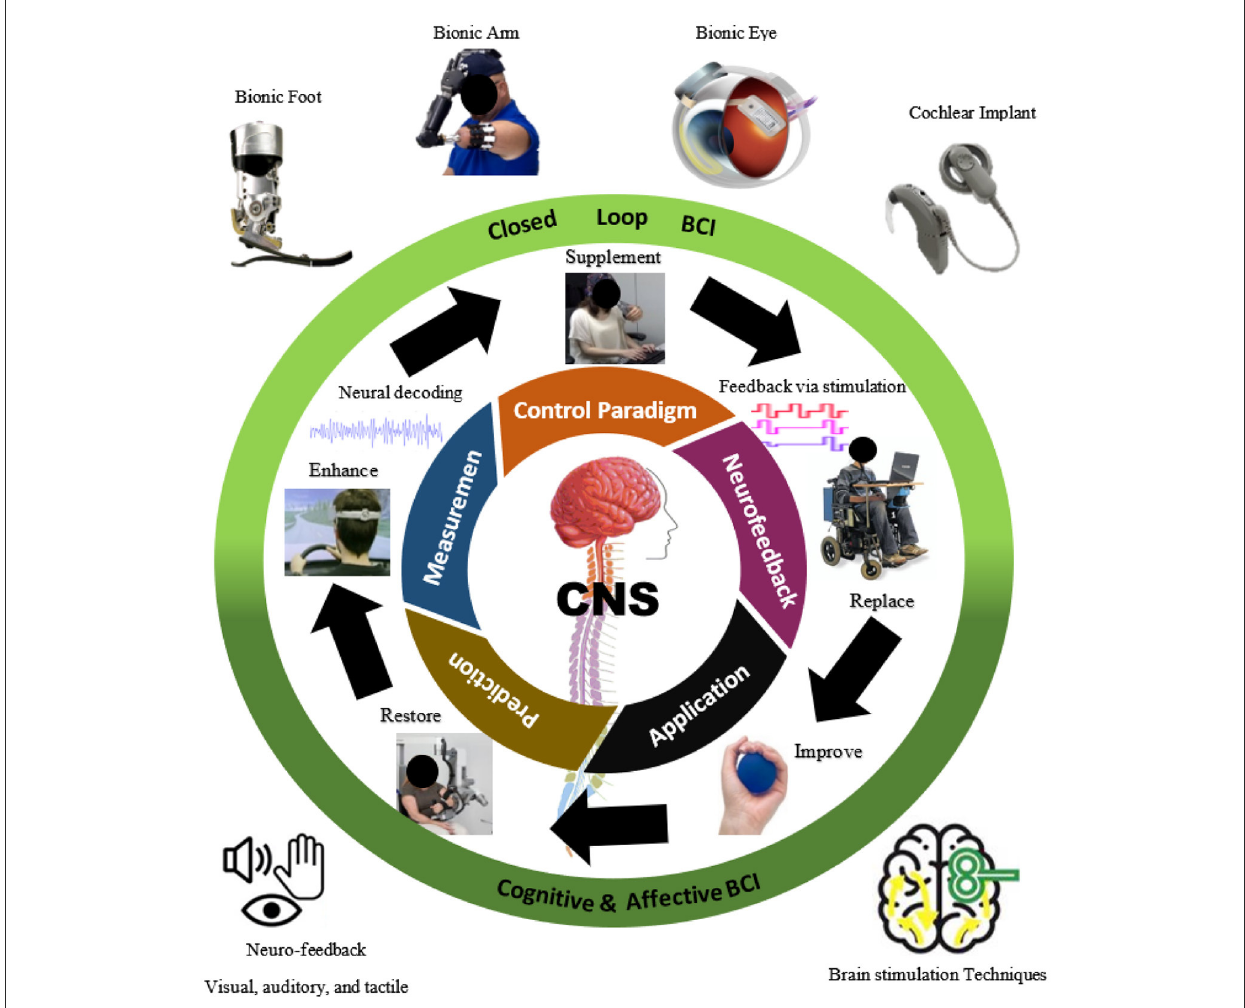
FIGURE2 A brain-computer interface (BCI)-based control/communication of closed-loop brain feedback or stimulation: methods, applications, and effects.